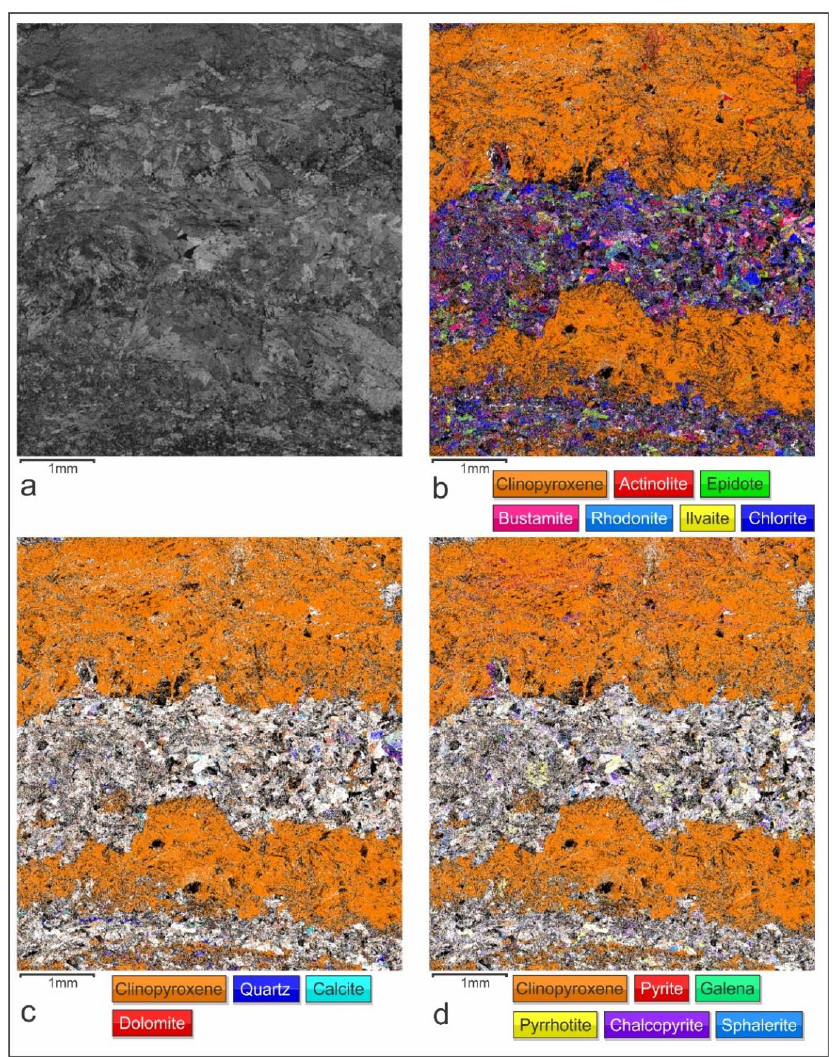
Figure 8. The Electron Back Scattered Diffraction (EBSD) maps illustrating the retrograde alterations of prograde pyroxene under high water activity: ( a ) Band contrast EBSD map; ( b ) Distribution of prograde clinopyroxene and retrograde hydrous silicates; ( c ) Distribution of prograde clinopyroxene and retrograde/hydrothermal carbonates and quartz; ( d ) Distribution of prograde clinopyroxene and hydrothermal sulfide mineralization. The EBSD mapping step size was 4.5 µm and the indexing rate was 74.0%.